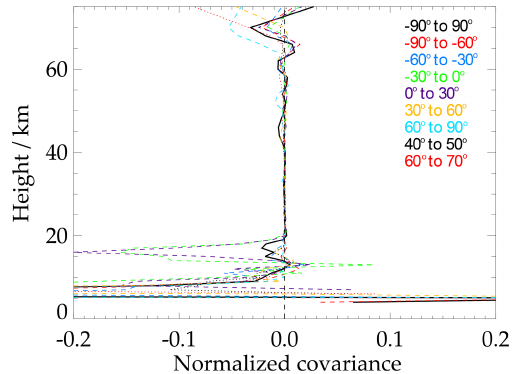
Figure 2. Correlation of the averaging kernel and ozone mixing ra- tio for various latitude bands.